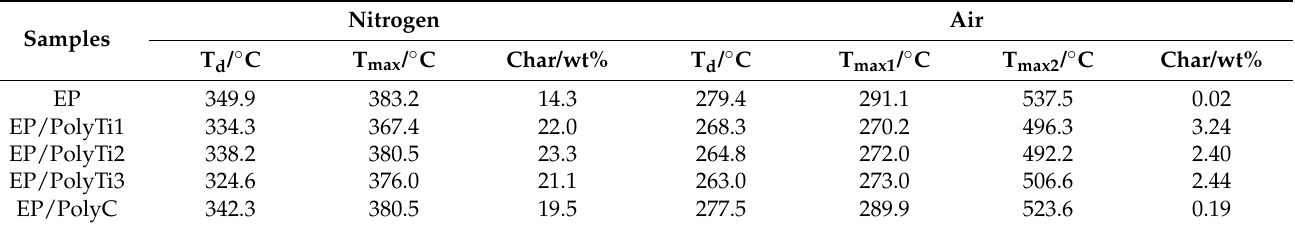
Table 4. The TGA data of the EP